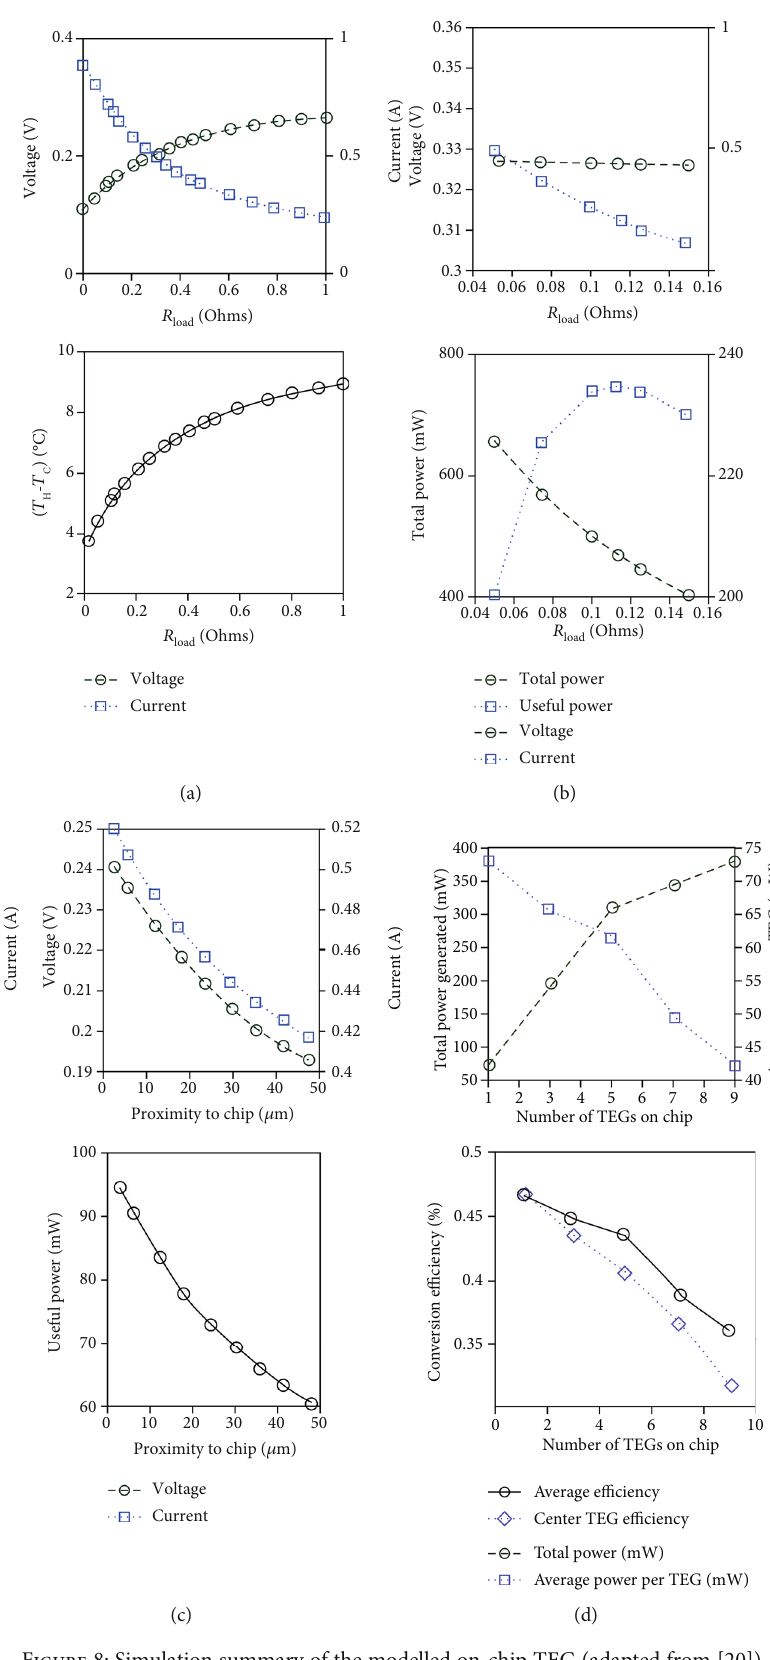
Figure 8: Simulation summary of the modelled on-chip TEG (adapted from